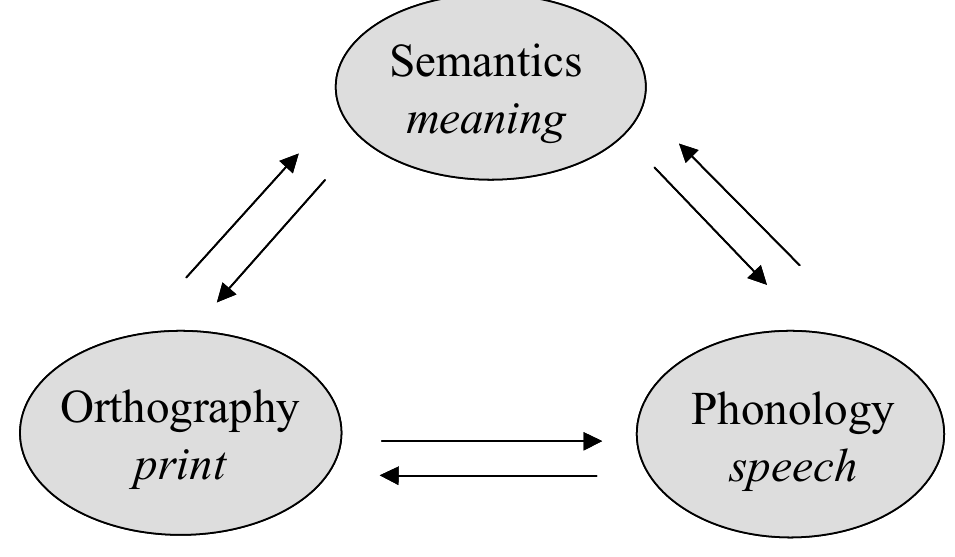
Figure 1. Triangle model of reading (after Seidenberg & McClelland, 1989). In this model, the mappings between orthography to phonology comprise the phonological pathway ; mappings between orthography and phonology via semantics comprise the semantic pathway